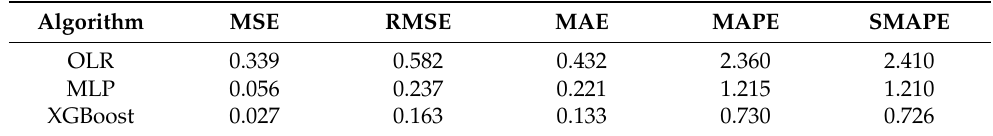
Table 9. Evaluation indexes of each algorithm in Chongqing.